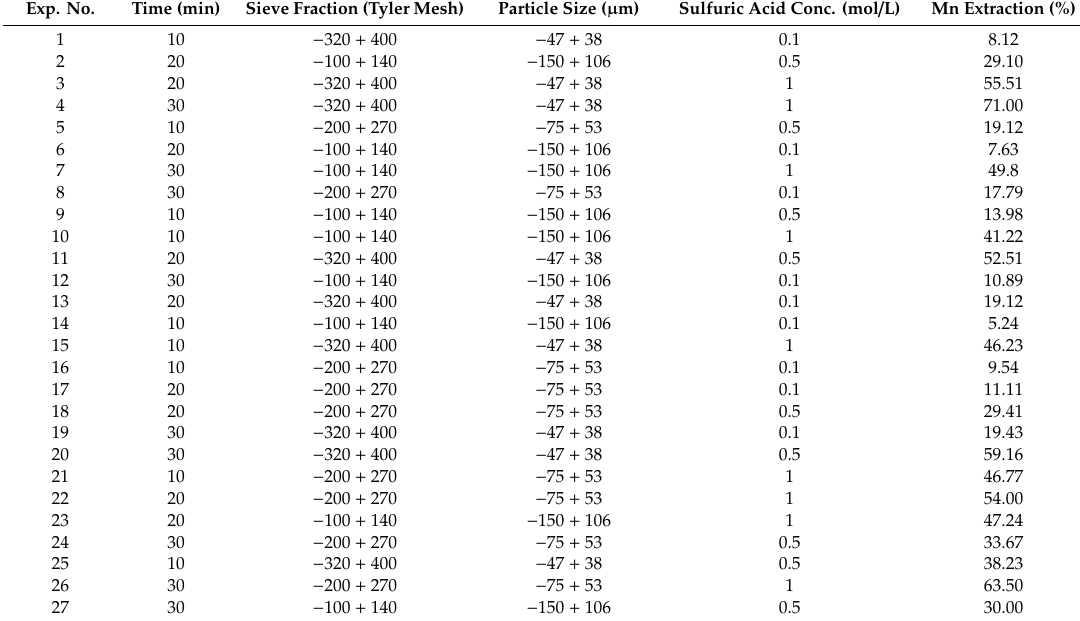
Table 3. Experimental configuration and Mn extraction data.